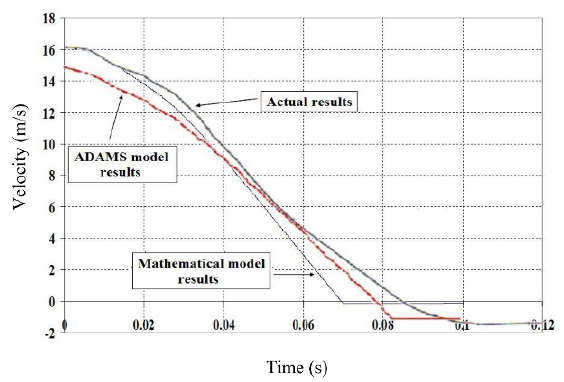
Figure 9. Deceleration of the vehicle body.